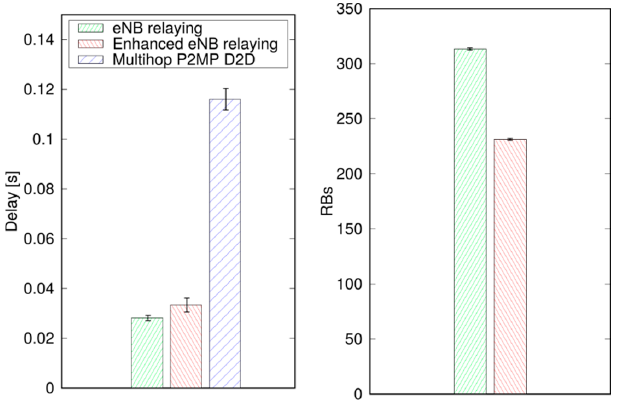
Figure 14. 95th percentile of delay ( left ) and average allocated RBs in downlink (DL) ( right ).